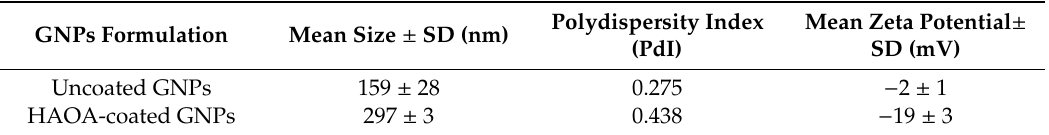
Table 1. Mean particle size, polydispersity index (PdI) and mean zeta potential of uncoated GNPs and HAOA-coated GNPs. Data are present as mean ±